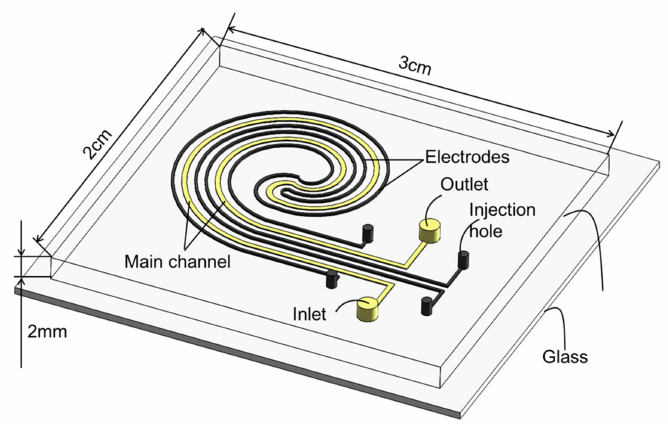
Figure 1. Schematic of the polydimethylsiloxane (PDMS)-glass microfluidic chip for the liquid-metal-based magnetohydrodynamic (MHD) micropump.